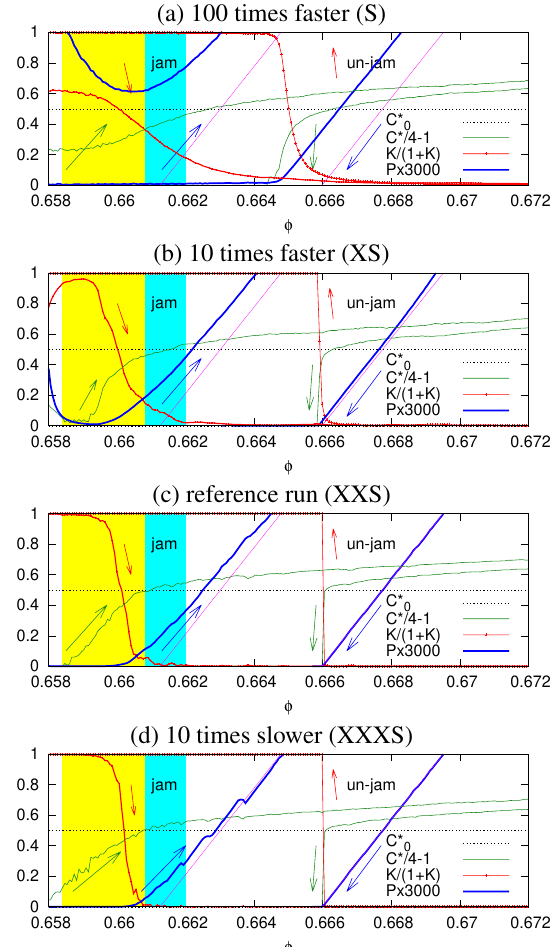
Figure 5. Zoom into the jamming / un-jamming regime, where the simulation in panel (c), with strainrate ˙ ε v = 1 . 05 × 10 − 6 s − 1 , is used as reference case. Shaded areas are explained in the main text, and the arrows indicate the direction in which the physi- cal quantities develop during jamming / un-jamming. The simula- tions are the same as in the previous subsection